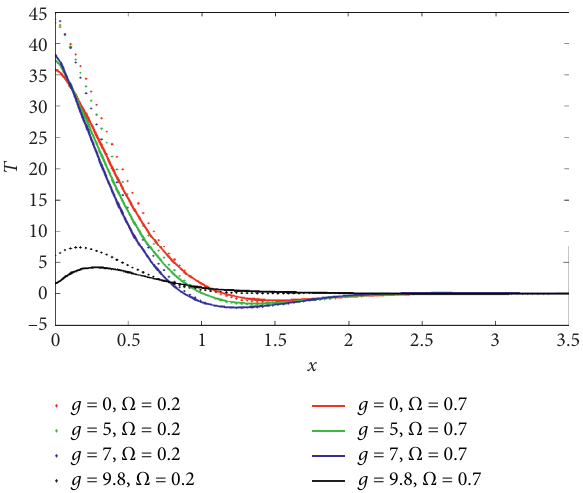
Figure 20: Stress σ x with laser pulse “ t ” and rotation. xx concerning